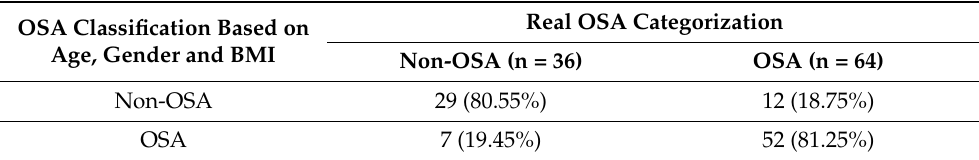
Table 4. Prediction of OSA classification, based on age, gender and BMI using AI (the table shows the number of cases per 100 patients and the percentage distribution of scores within the non-OSA and OSA categories). OSA: obstructive sleep apnoea.